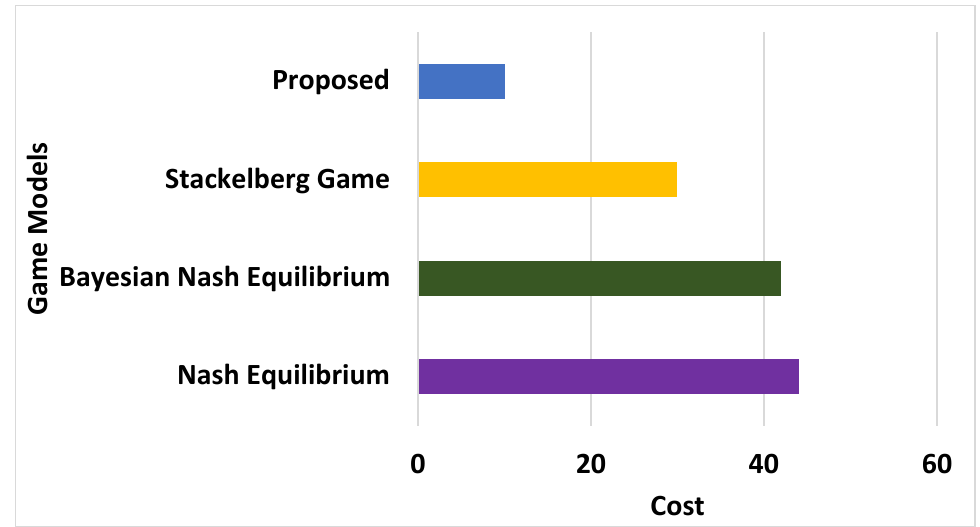
Figure 8. Comparative analysis of cost.